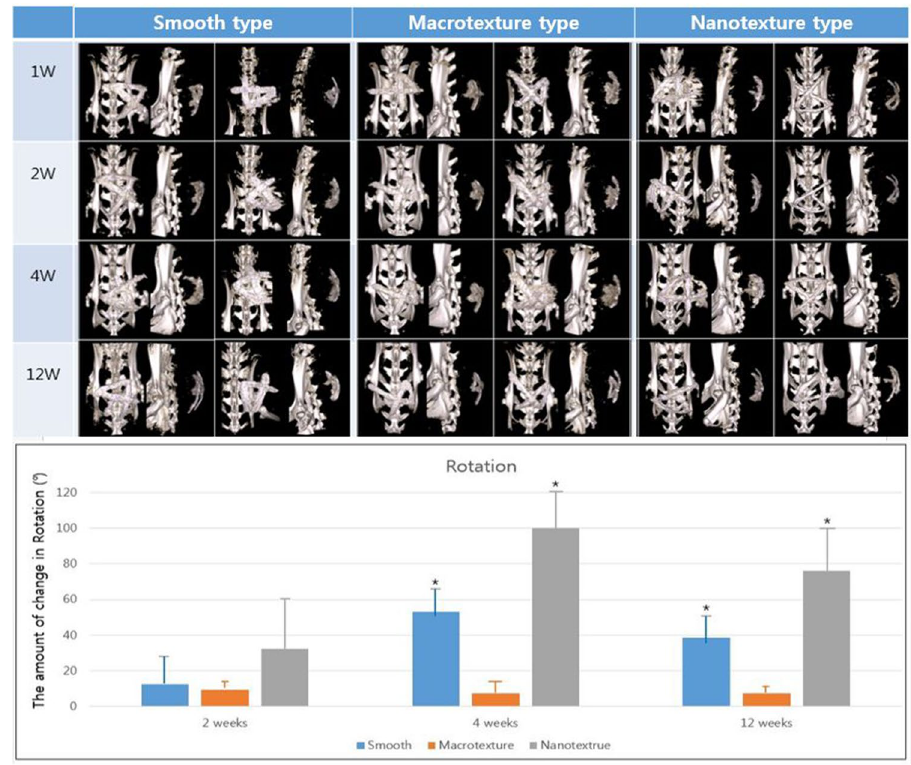
Figure 6. Location of the three different types of silicone implants. Micro-computed tomography scans performed at 1, 2, 4, and 12 weeks after breast implant insertion. Three types of implants with different topographies (smooth, macrotexture, and nanotexture type). Bar graph showing the mean value of rotation. The amount of change in rotation was measured at 2, 4, and 12 weeks from the previous position. Black asterisks in the bars represent P values indicating significant differences between the groups ( P <